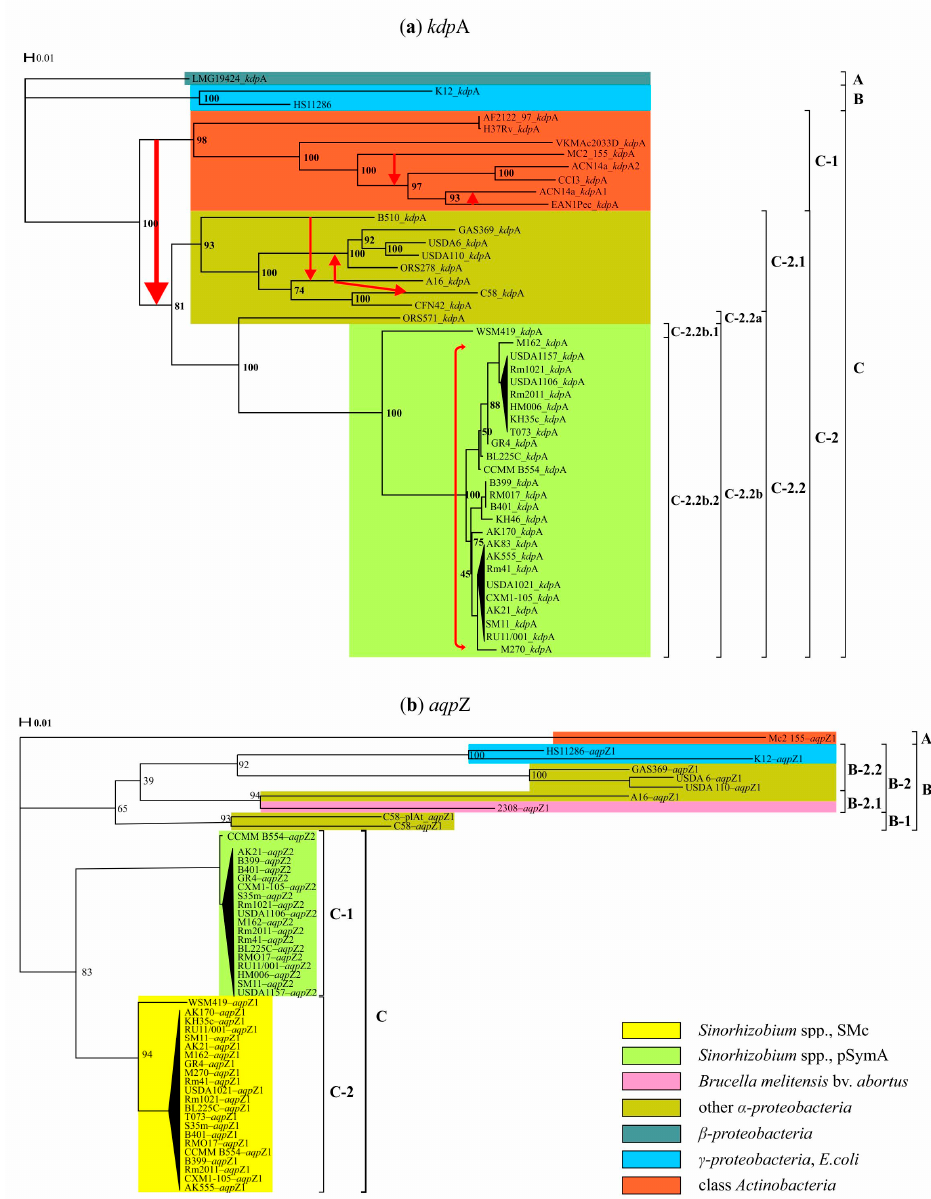
Figure 4. Phylogenetic analysis of kdp A ( a ) and aqp Z ( b ) gene sequences in α -, β - and γ -proteobacteria, as well as Actinobacteria . The nucleotide substitution models selected for the analysis were TVM + F + I + G4 for kdp A and TPM3u + F + I + G4 for aqp Z. The scale bars were 0.01 for kdp A and aqp Z nucleotide substitutions per site.